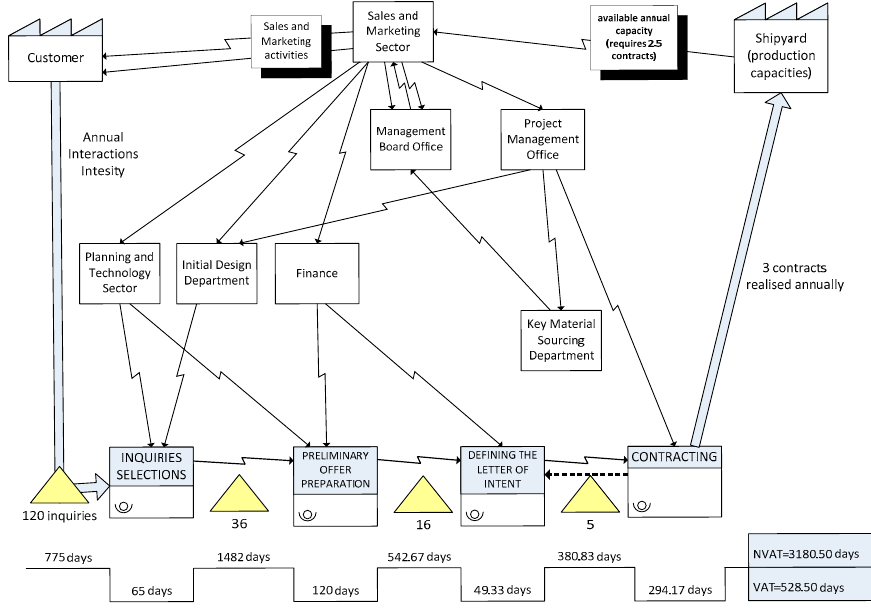
Figure 4. Future state Value Stream Map.